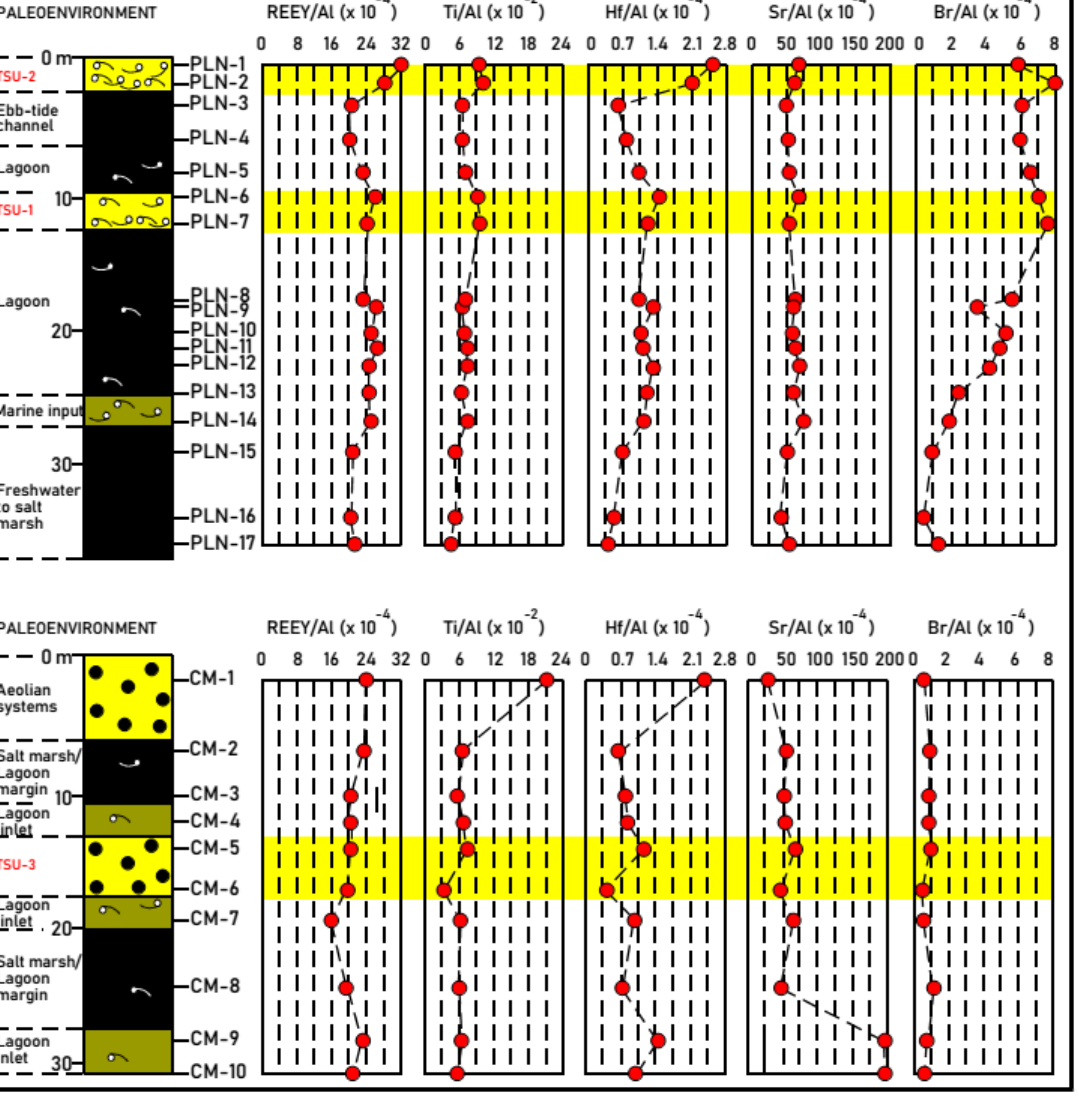
Figure 12. Vertical distribution of the REEY/Al, Ti/Al, Hf/Al, Sr/Al and Br/Al ratios. REEY: REE+Y.